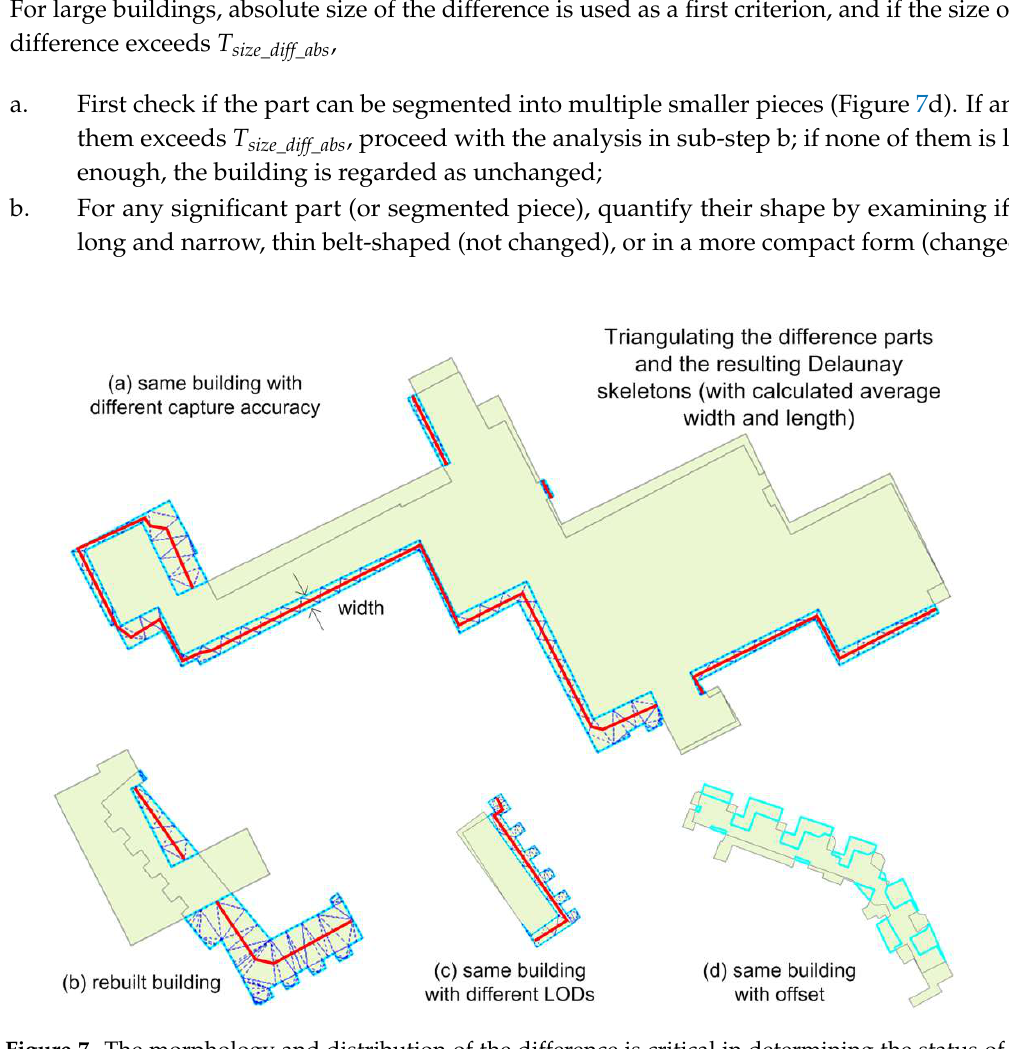
Figure 7. The morphology and distribution of the difference is critical in determining the status of change. By triangulating the difference polygons and extracting the skeletons (red lines), we were able to quantify the morphology (e.g., length and average width) of the difference.